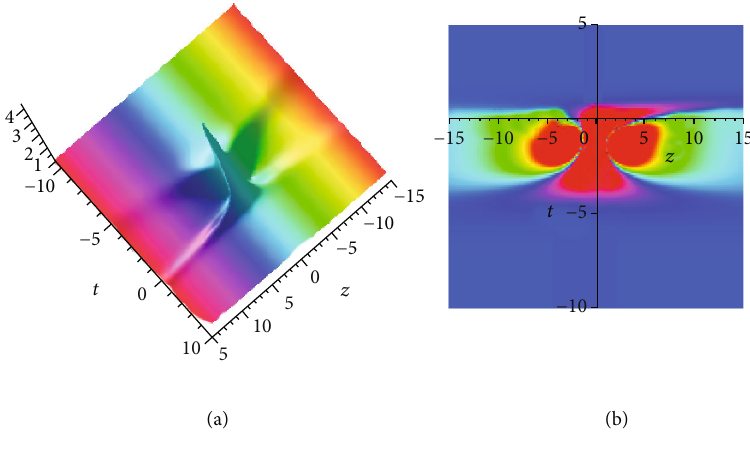
Figure 21: Plots of lump-periodic